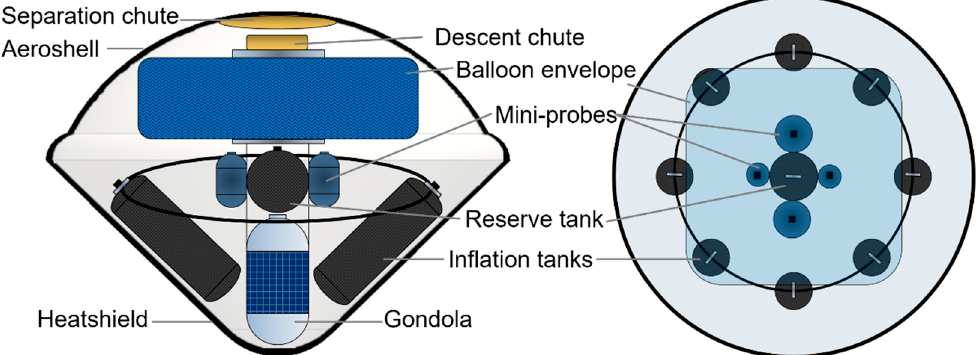
Figure 8. Schematic of the entry probe showing the notional accommodation of the subsystems inside the probe. ( Left ) Side view, ( Right ) Top view. Table 5. Mass breakdown of the entry